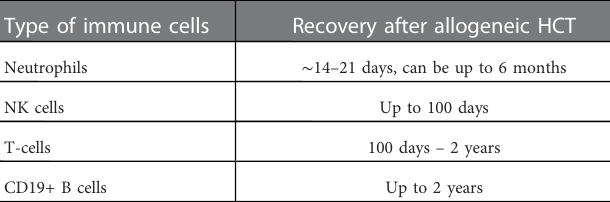
TABLE 1 Adapted from Ogonek et al (65).